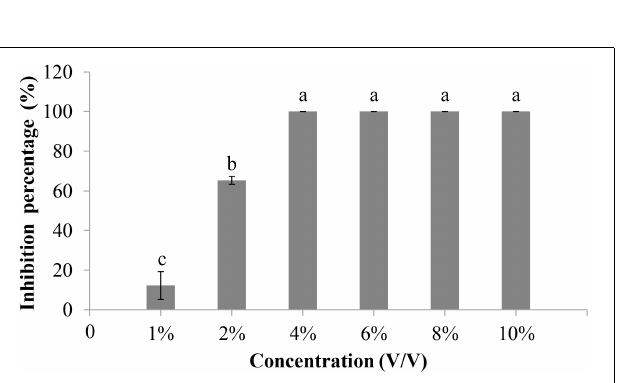
FIGURE 3 | Inhibitory rates of culture filtrates of F. proliferatum 10R-7 of different concentrations on V.